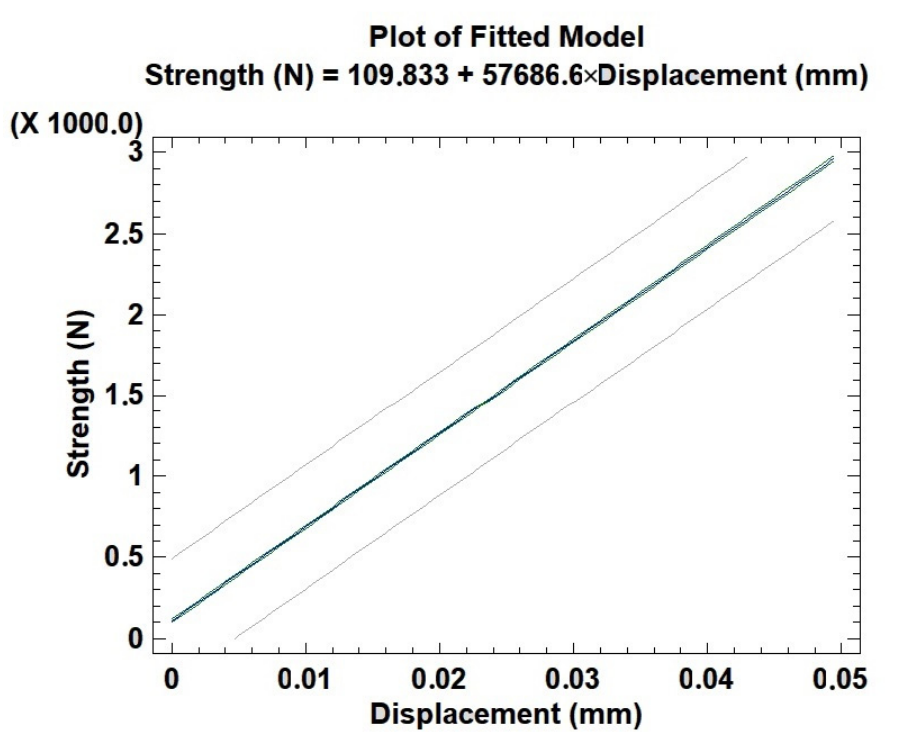
Figure 10. Graph of the adjusted model Test 2. Composite material 50% fly ash (D: 20 mm/E: 70 mm).